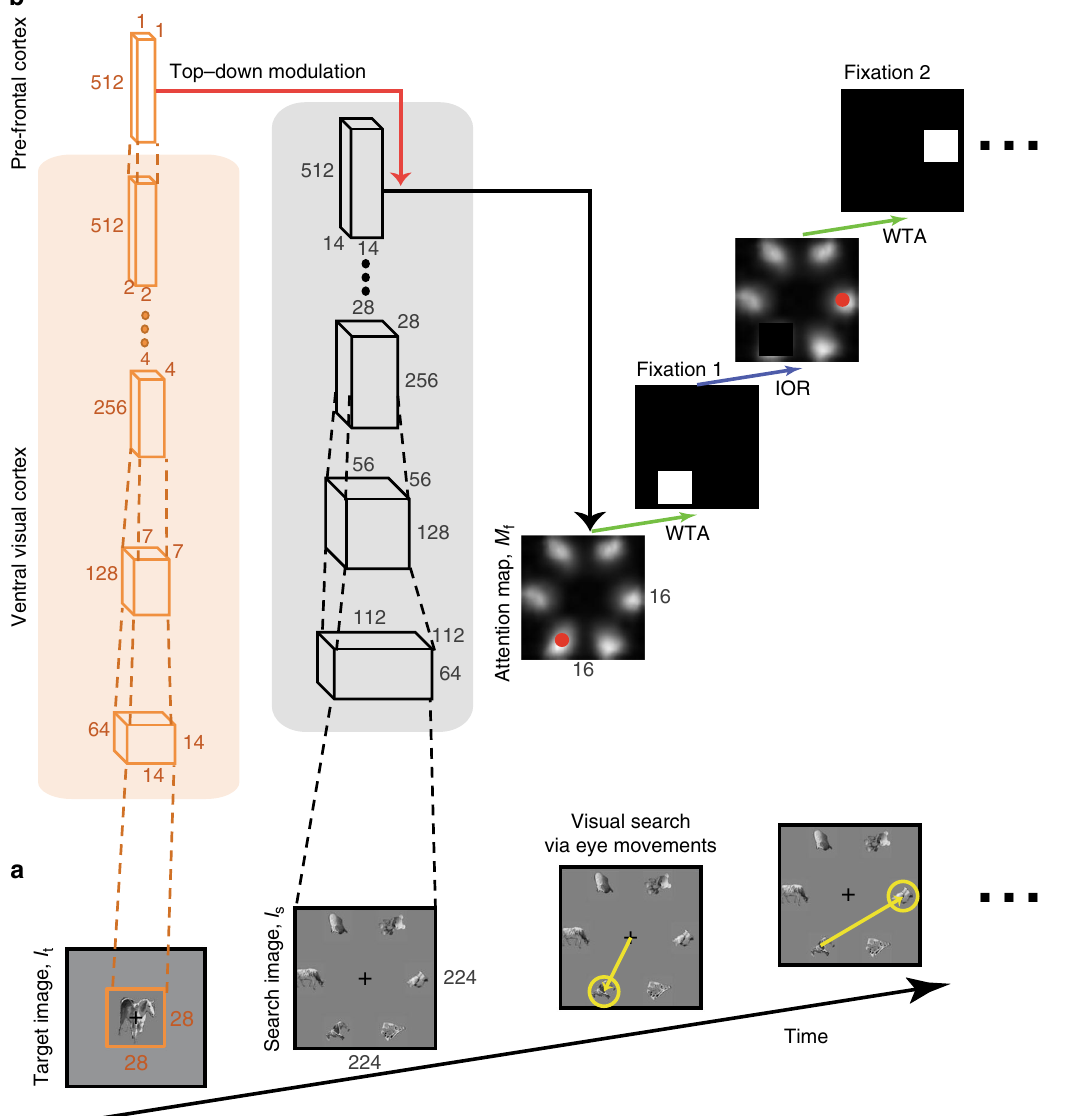
Fig. 2 Model schematic. a Sequence of events during the visual search task. A target image is presented, followed by a search image where subjects move their eyes to locate the target object (see Fig. 1 for further details). b Architecture of the model, referred to as Invariant Visual Search Network (IVSN). The model consists of a pre-trained bottom-up hierarchical network (VGG-16) that mimics image processing in the ventral visual cortex for the target image (orange box) and for the search image (gray box). Only some of the layers are shown here for simplicity, the dimensions of the feature maps are indicated for each layer. The model generates features in each layer when presented with the target image I t . The top-level features are stored in a pre-frontal cortex module that contains the task-dependent information about the target in each trial. Top-down information from pre-frontal cortex modulates (red arrow) the features obtained in response to the search image, I s , by convolving the target presentation of I t with the top-level feature map from I s , generating the attention map M f . A winner-take-all mechanism (WTA, green arrow) chooses the maximum in the attention map (red dot) as the location for the next fi xation. If the target is not found at the current fi xation, inhibition of return is applied (IOR, blue arrow), the fi xation location is set to 0 in the attention map and the next maximum is selected. This process is repeated until the target is target was signi fi cantly below the number expected from random exploration of the 6 possible locations, which would require 3.5 fi xations in this experiment (Fig. 3e, p < 10 − 15 , two-tailed t -test, t = 10, df = 4473). Even in the fi rst fi xation, subjects were already better than expected by chance (performance = 26.4 ± 4.1%